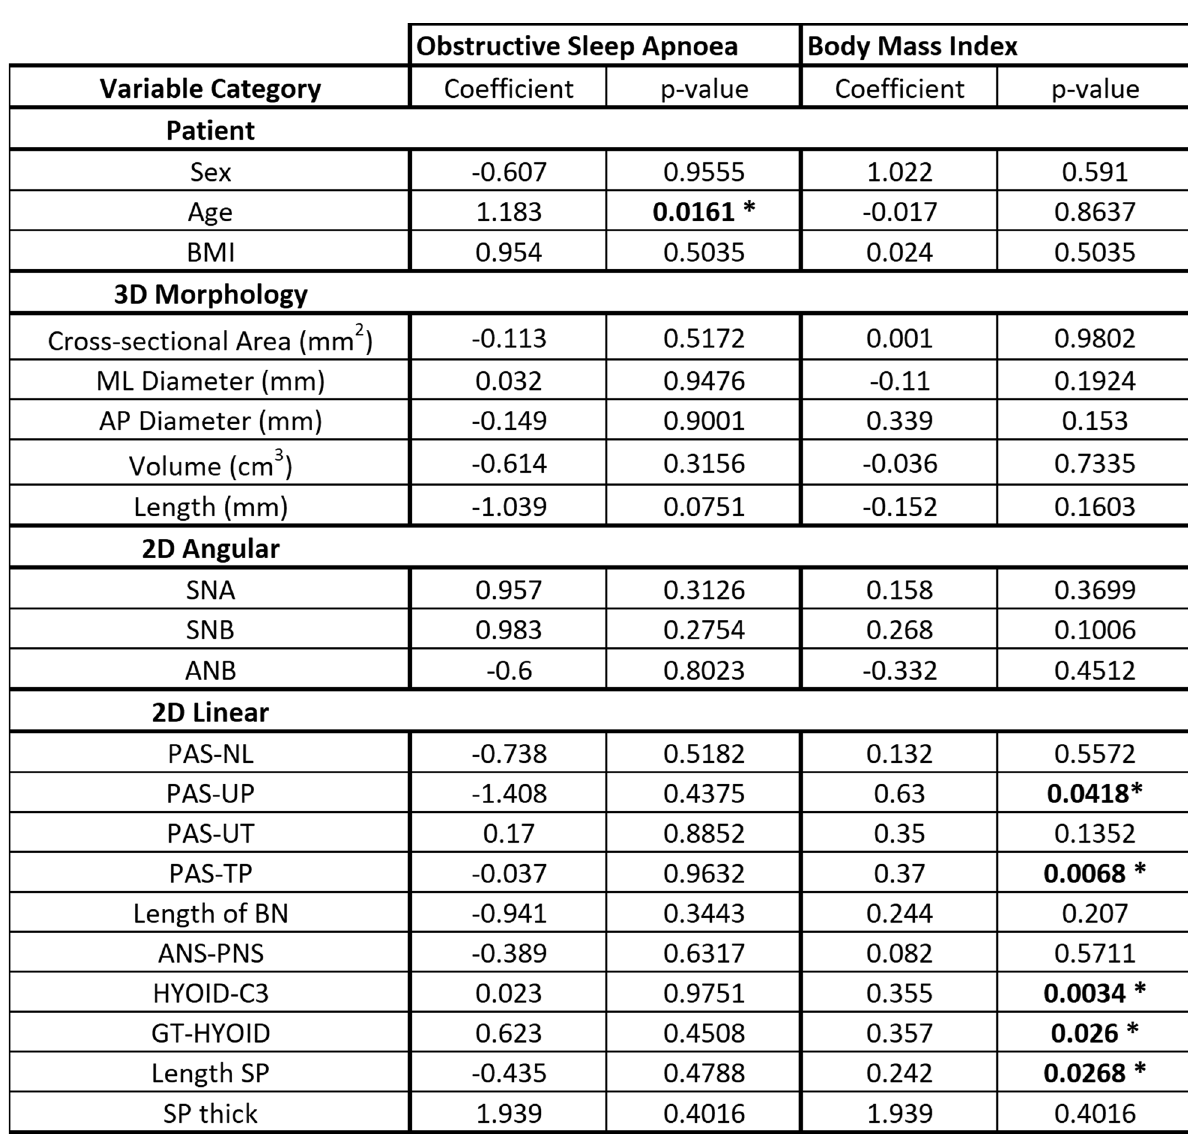
Table II. Relationship between OSA, BMI and other